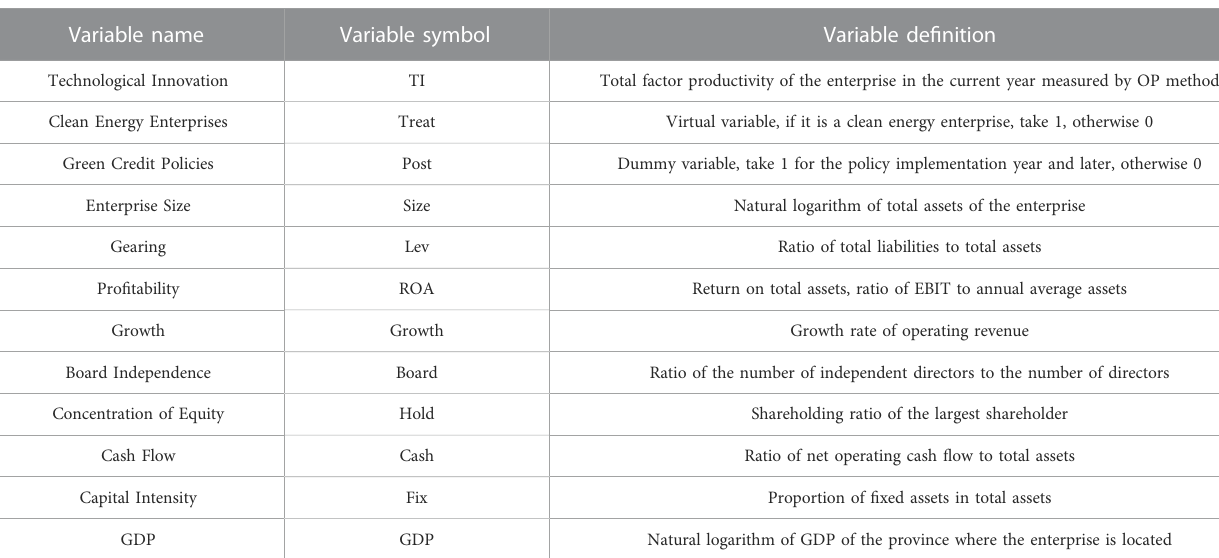
TABLE 1 Variable